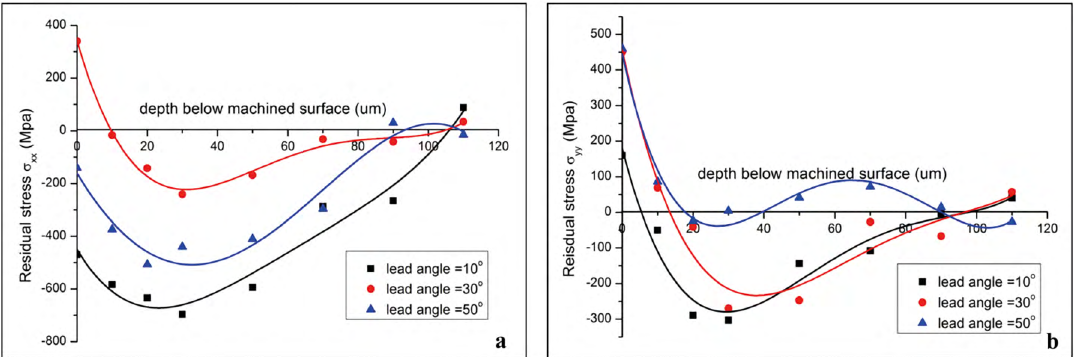
, (b) σ , ( a =0.3mm, a =0.2mm, V =60m/min, f =0.06mm/rev, tilt xx yy p e eff